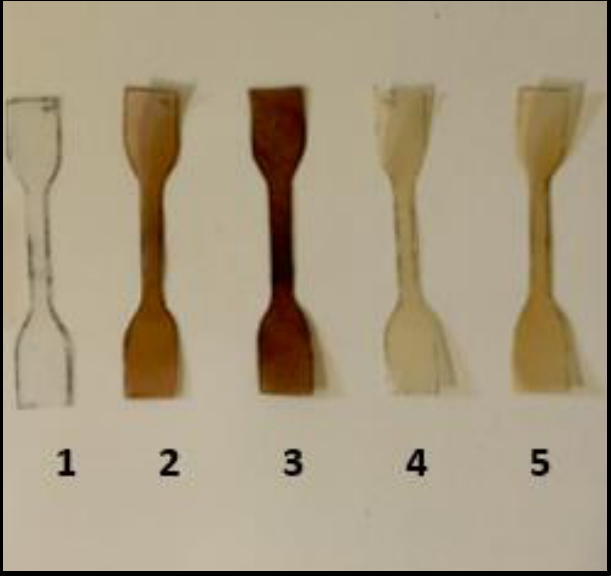
Figure 3. Preparation of composite specimens. 1: BioPE 100%; 2: BioPE-30% shell; 3: BioPE-30% pulp; 4: BioPE-30% unroasted argan cake; 5: BioPE-30% roasted argan cake.